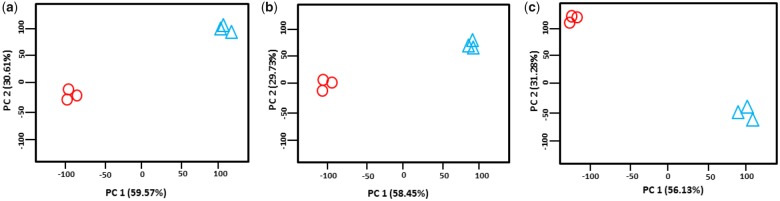
—PCA plots of all differentially expressed transcripts at 0‰ (circles) and 15‰ (triangles) for the three Macrobrachium species: (a) M. australiense, (b) M. tolmerum, and (c) M. novaehollandiae.